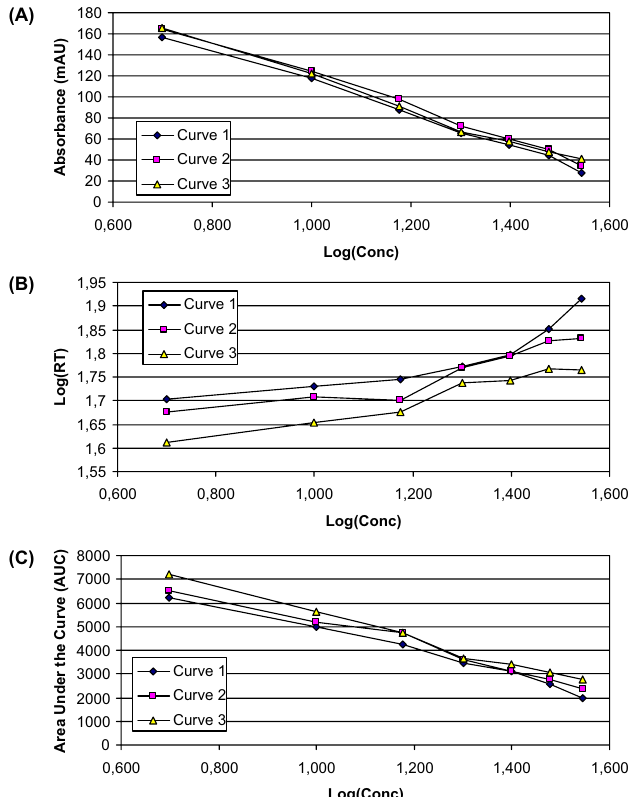
FIGURE 5 - Calibration curve for microplate assay employing Escherichia coli (ATCC 8739) inoculated at 5% using A) endpoint-reading mode, B) kinetic-reading mode (RT) and C) kinetic-reading mode (AUC). Curves 1, 2 and 3 are independent analytical curves prepared with solutions containing various concentrations (5, 10, 15, 20, 25, 30 and 35 m g mL -1 ) of apramycin